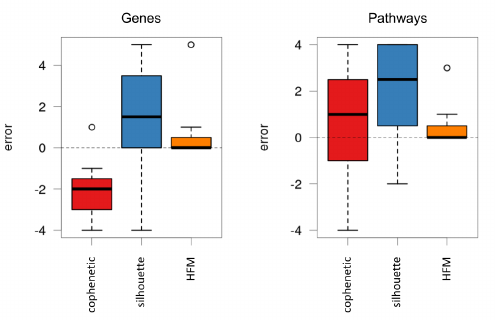
Figure 3. Difference between the expected number of components and those estimated over 100 sim- ulations using the cophenetic correlation coefficient, the silhouette method and the hierarchical factorisation model (HFM), for genes and pathways, respectively. As can be seen, the hierarchical model provides the smallest differences in both spaces, providing in most cases the exact number of expected